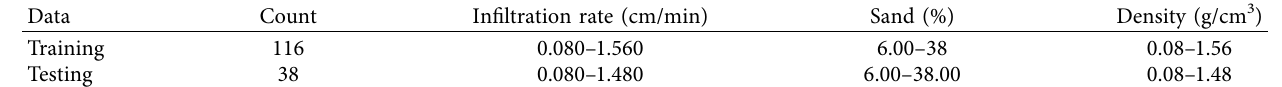
Table 1: Training and testing data used.